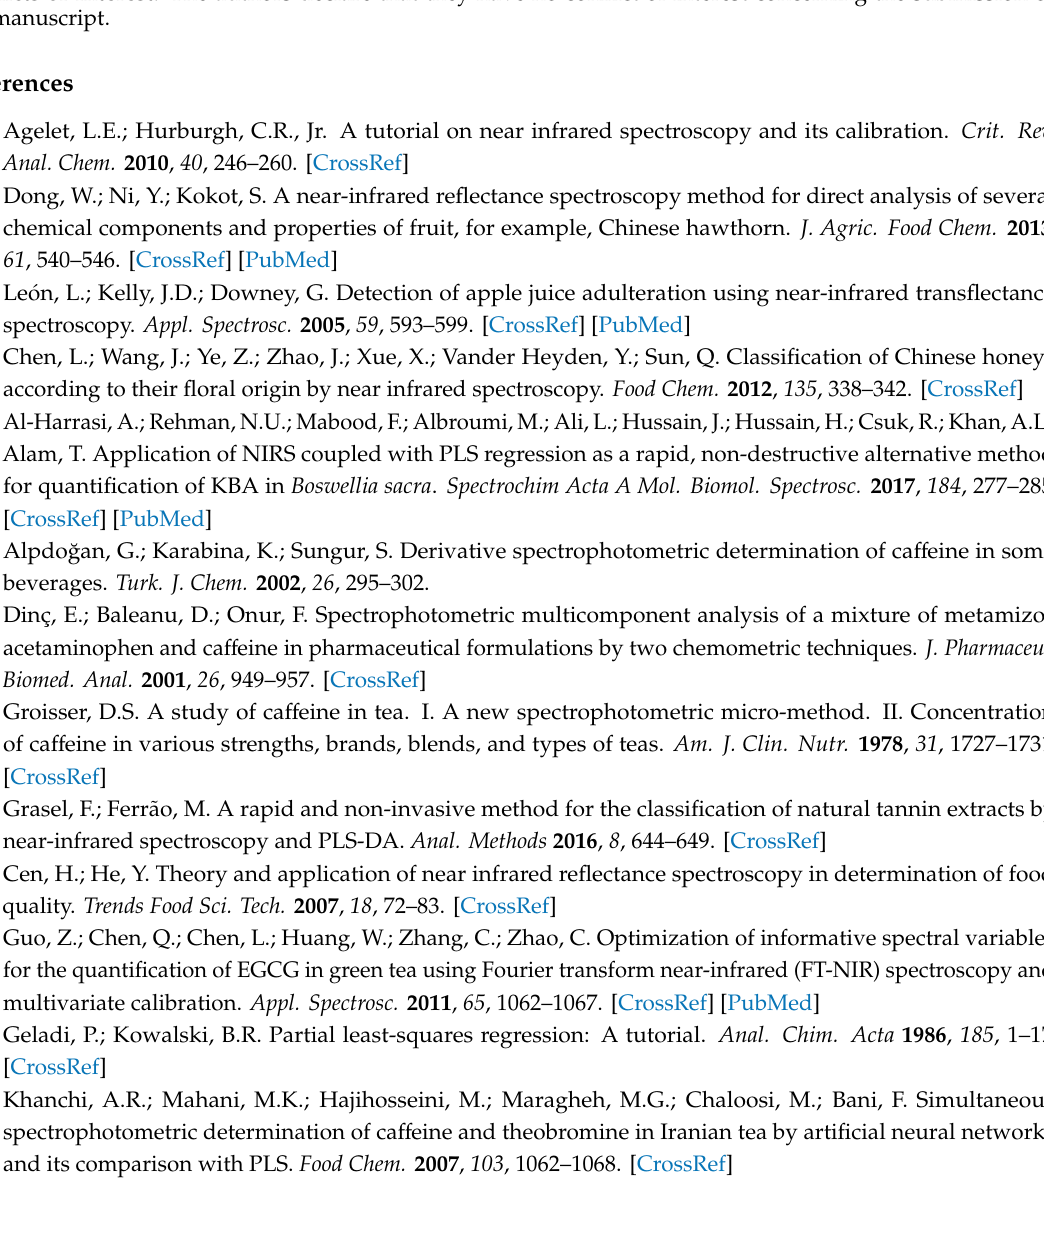
Figure S1: HPLC chromatograms of all the ca ff eine standards as well as tea samples at 2.07 min retention time. Figure S2: Standard calibration curve of ca ff eine for HPLC